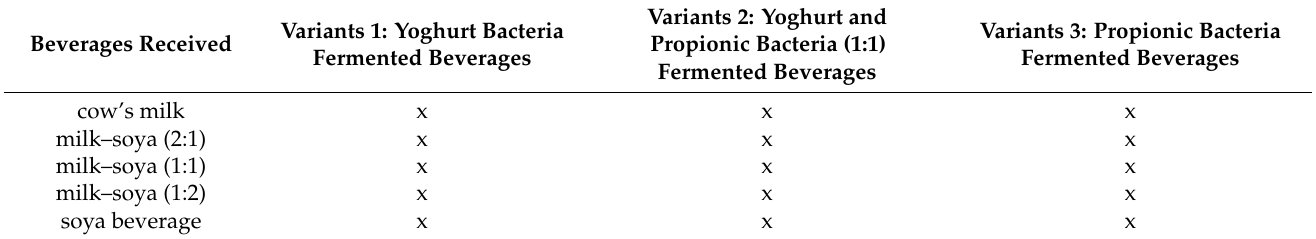
Table 1. The schedule for the preparation of milk, milk–soya, and soya beverages fermented using different starter cultures and stored at 5 ◦ C for 21